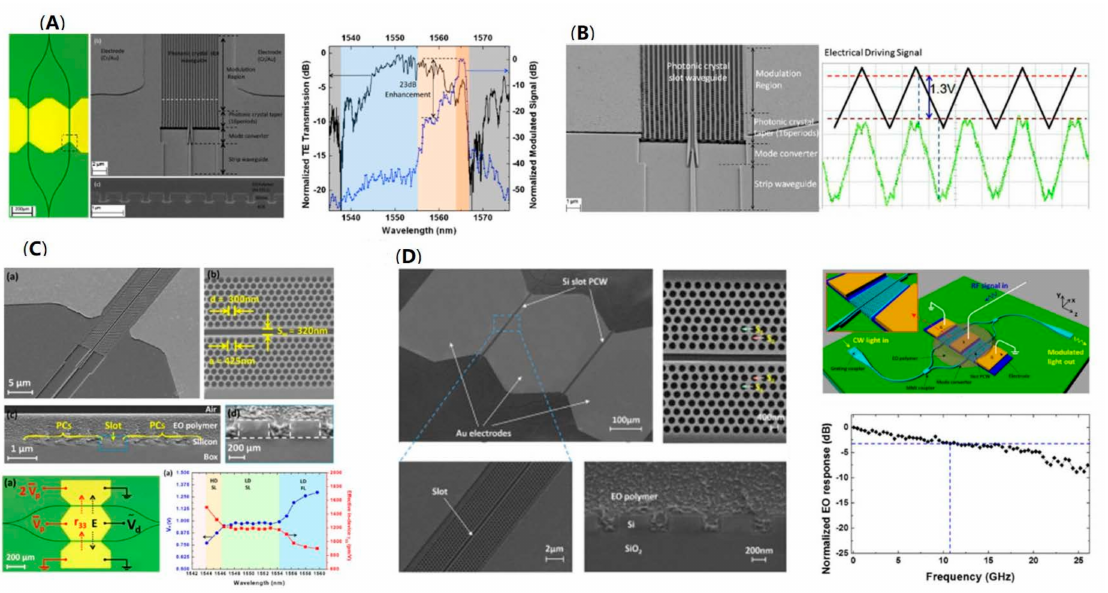
Figure 10. Silicon-based polymer photonic crystal modulator. ( A ) Optical and SEM images of the polymer-infiltrated silicon photonic crystal slot modulator and its wavelength dependence of normalized modulated signal (blue line) and normalized optical transmission (black line) [55]. ( B ) SEM picture of the 320 nm-wide silicon photonic crystal slot waveguide. The modulation measurements showing a low V π of 1.3 V [56]. ( C ) SEM images of the band-engineered, EO polymer- refilled silicon slot photonics crystal modulator. Measured V π and corresponding calculated effective r 33 versus wavelength (at 100 kHz) [57]. ( D ) SEM images of the polymer-refilled photonic crystal modulator with RC time constant engineered and a backside gate technique. Measured normalized EO response of the modulator as a function of RF frequency indicates a 3 dB modulation bandwidth of 11 GHz [58].